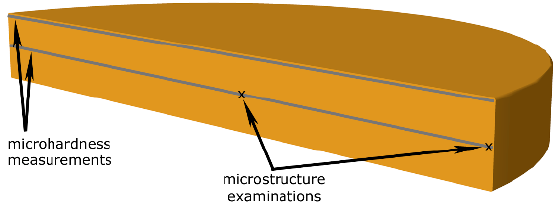
Figure 1. Schematic depiction of analyzed locations.